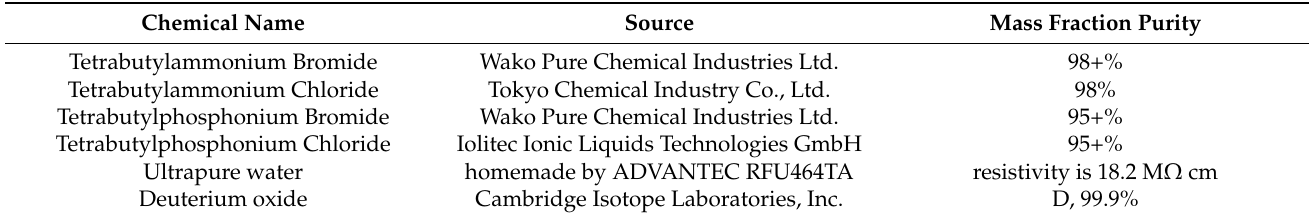
Table 1. Information on chemical